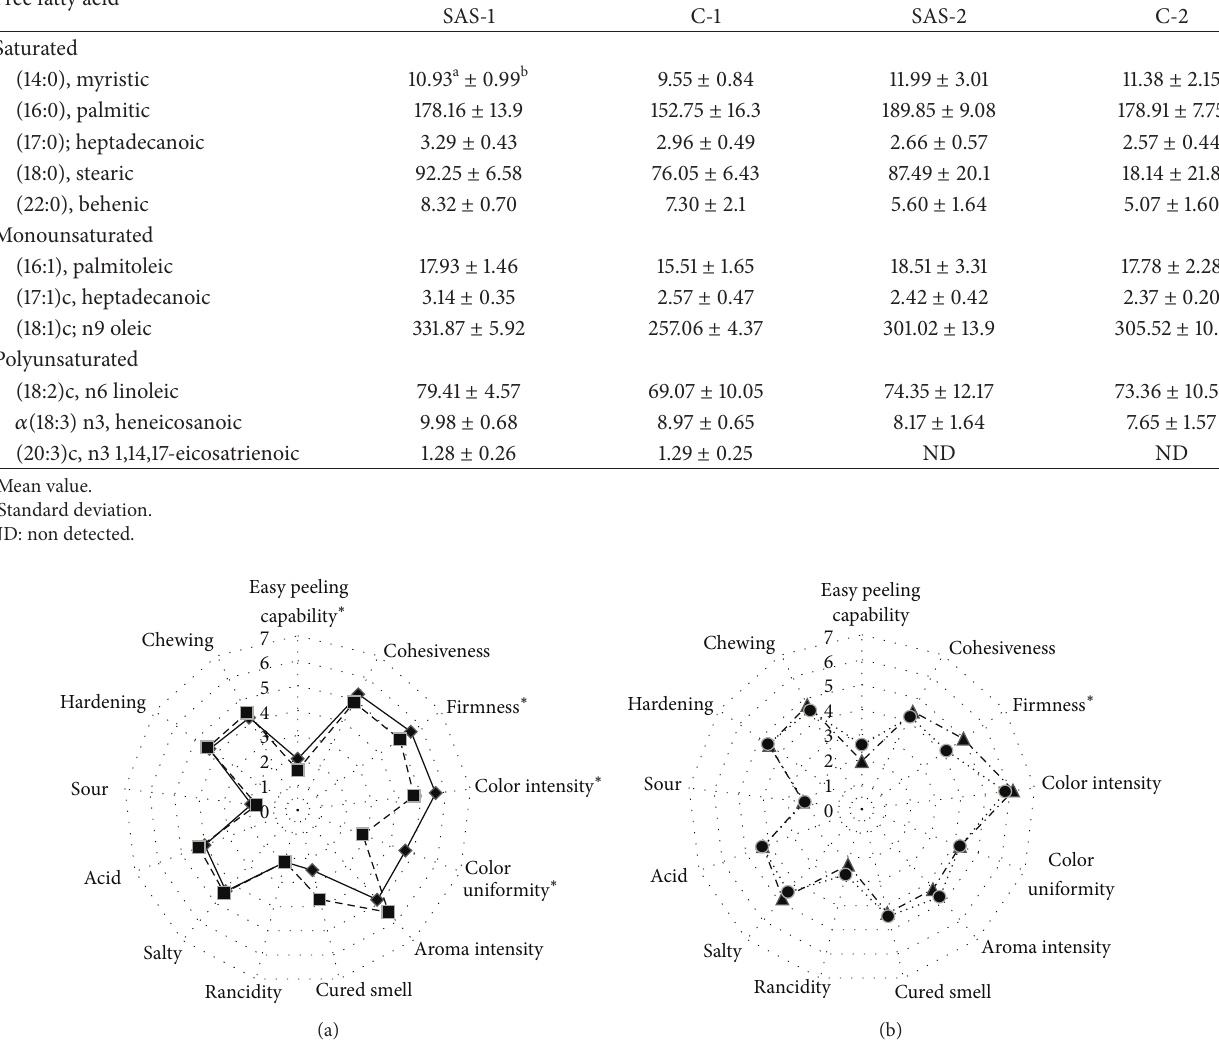
Table 4: Free fatty acid (FFA) profile [ mg fatty acid/g of fat ] of dry sausages manufactured with indigenous starter cultures. Free fatty acid